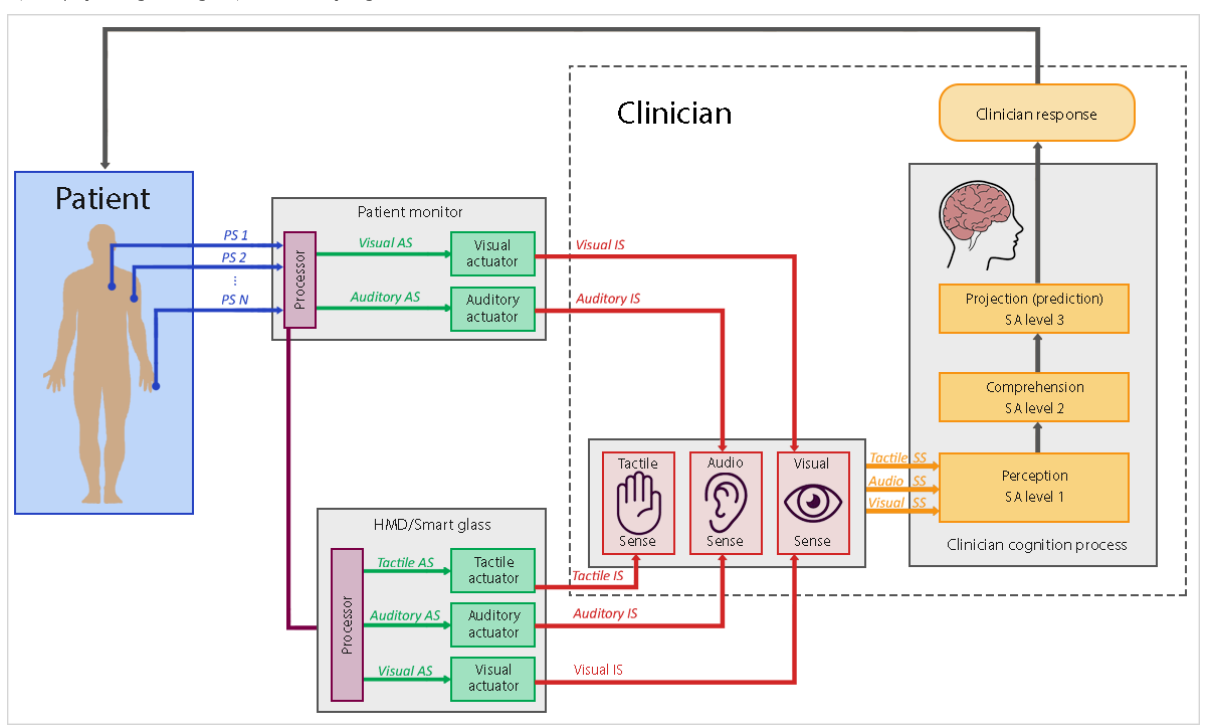
Figure 3. Interaction mechanism between the head-mounted display and the clinician. AS: actuator signal; EDS: external device signal; IS: interaction signal; PS: physiological signal; SS: sensory